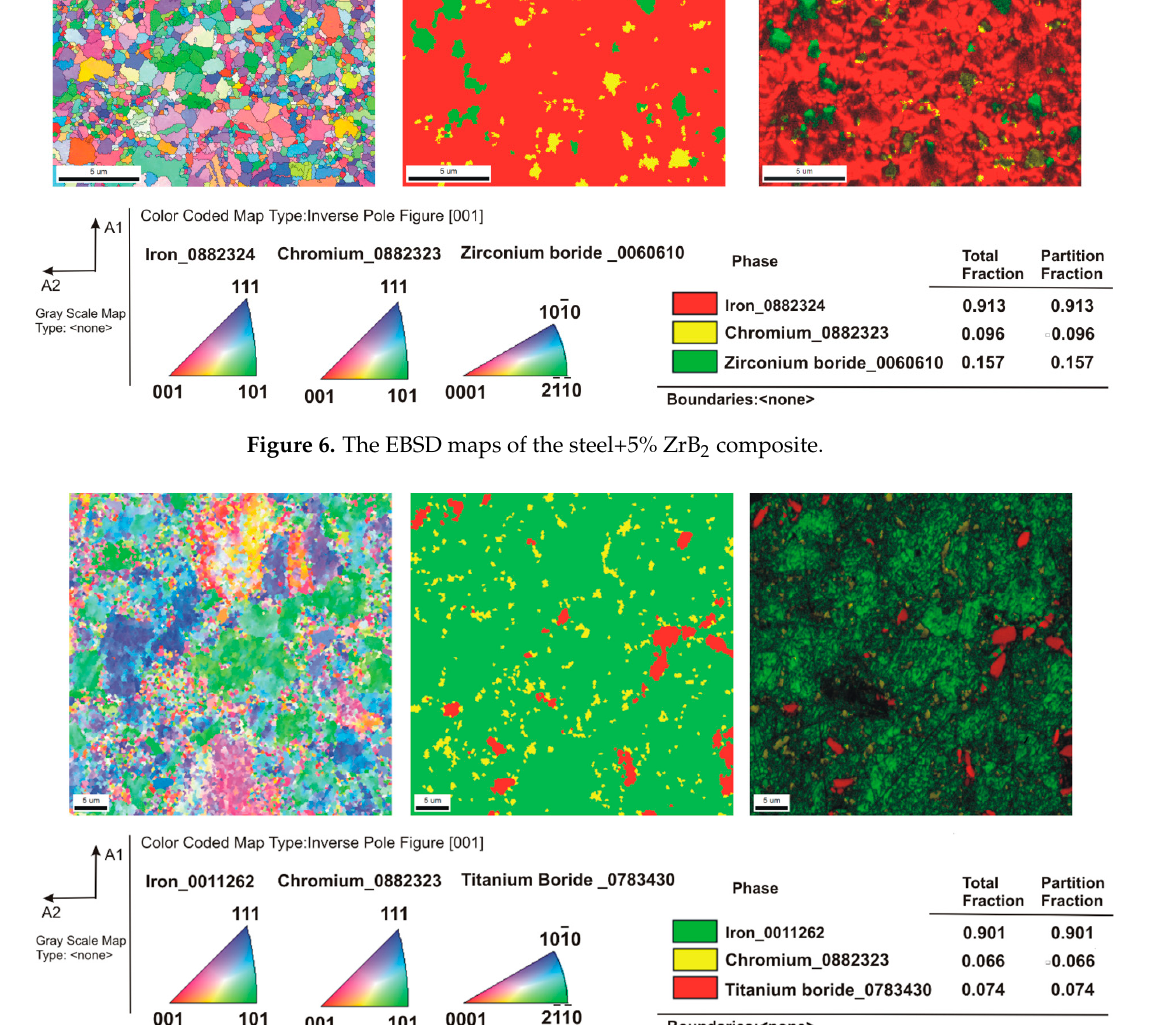
Figure 7. The EBSD maps of the analysis of the steel + 5% TiB 2